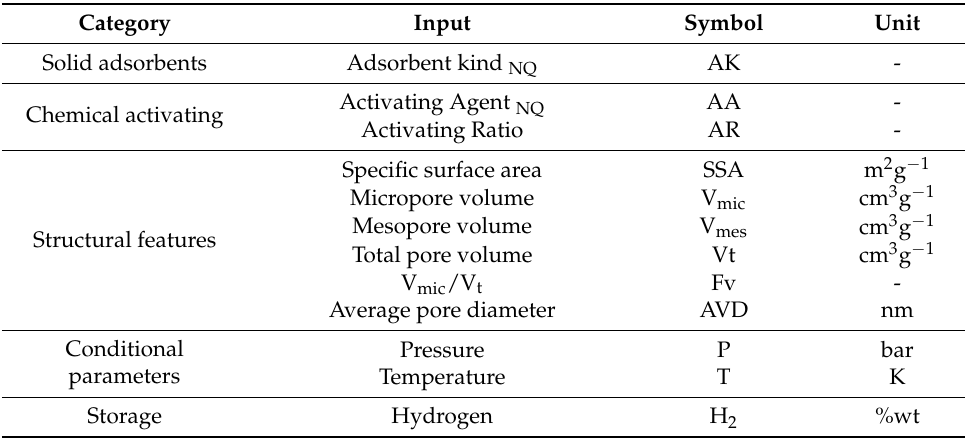
Figure 2. The process of datasets preparation and modeling via ML. Table 2. The description of independent variables and